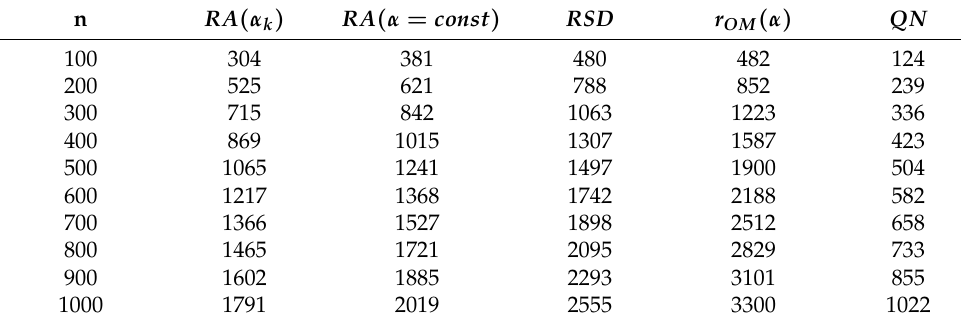
Table 2. Function f 2 ( x ) minimization results.